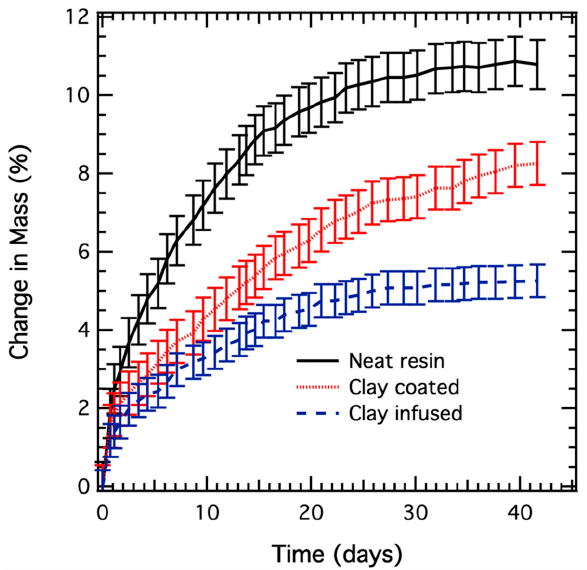
Figure 4. Moisture absorption behaviors of different carpet composites at 80 °C.